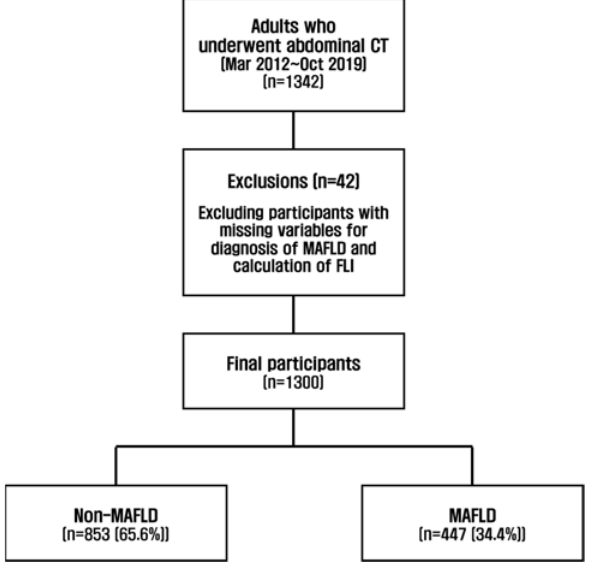
Figure 2. Flowchart of participants’ inclusion and exclusion.